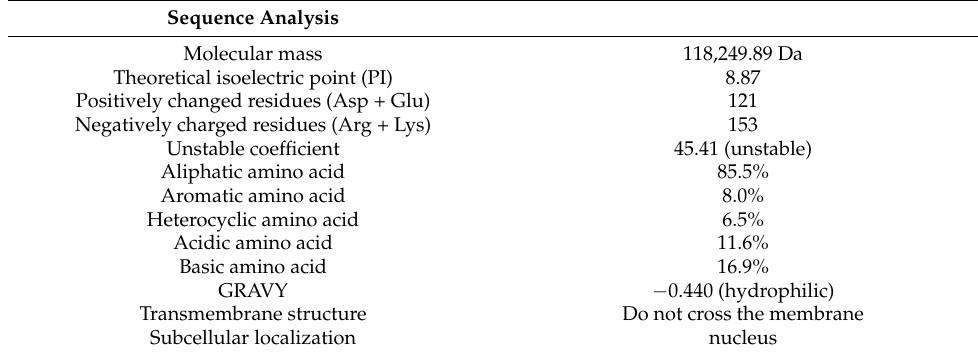
Figure 2. Multiple sequence alignment of CsSDG36 and ATX4 proteins from other species. Conserved domains of ATX4 proteins were marked with red boxes, including one PWWP, three PHD, one SET, and one PostSET domains. Table 1. Bioinformatic analysis of CsSDG36